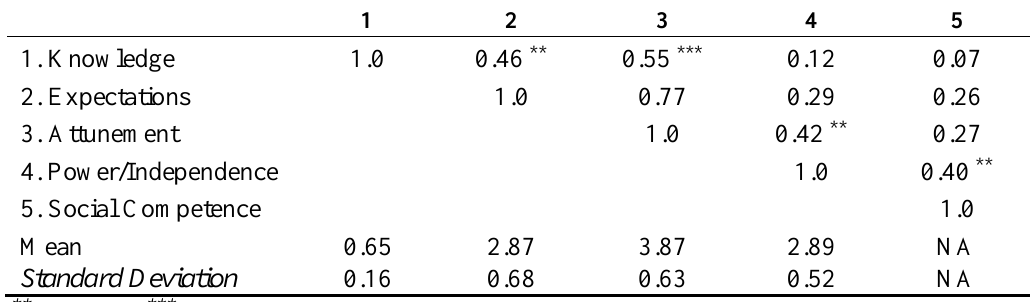
Table 3. Correlations and Descriptive Statistics for Knowledge, Expectations, Attunement, Power/Independence, and Social Competence Variables ( N = 39).